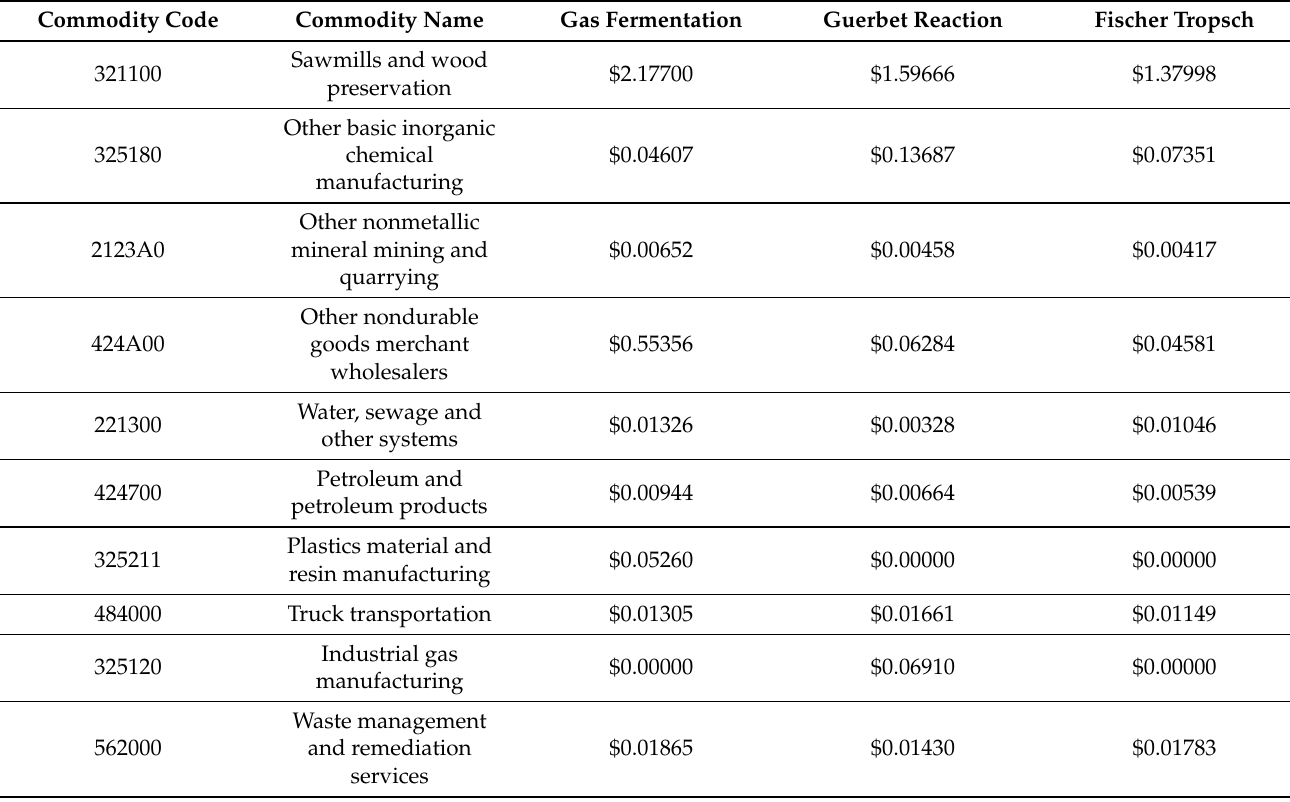
Table A2. Input purchases in 2012 producer prices per GGE for each new